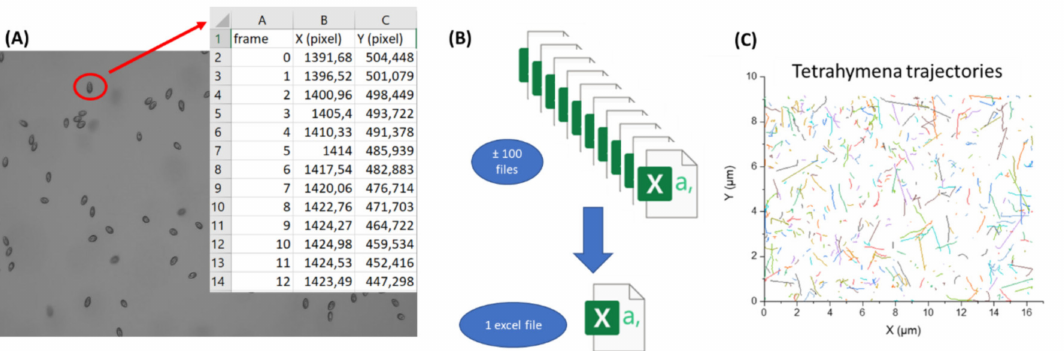
Figure 1. Experimental workflow for T. thermophila locomotion tracking and locomotor activity measurement. T. thermophila samples were transferred to six-well depression slides that were able to accommodate 100–200 µ L samples. Original video was captured for 1 min for each sample by a high-resolution CCD mounted onto upright microscope. Later, this 1 min video was handled by TGrabs tool for object identification. Finally, each individual cell’s locomotor trajectory and XY coordinates were tracked by the TRex tool. ( A ) The output result of XY trajectory from one individual T. thermophila cell. ( B ) Combining all the data from separate individual cells into a single spreadsheet file using VBA. ( C ) The trajectory footage of all T. thermophila movement captured in the